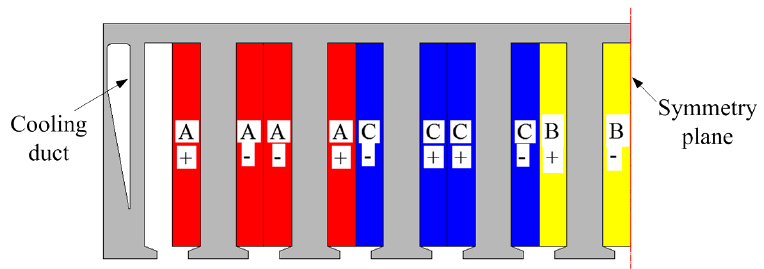
Figure 11. Incorporation of cooling ducts into armature cores.